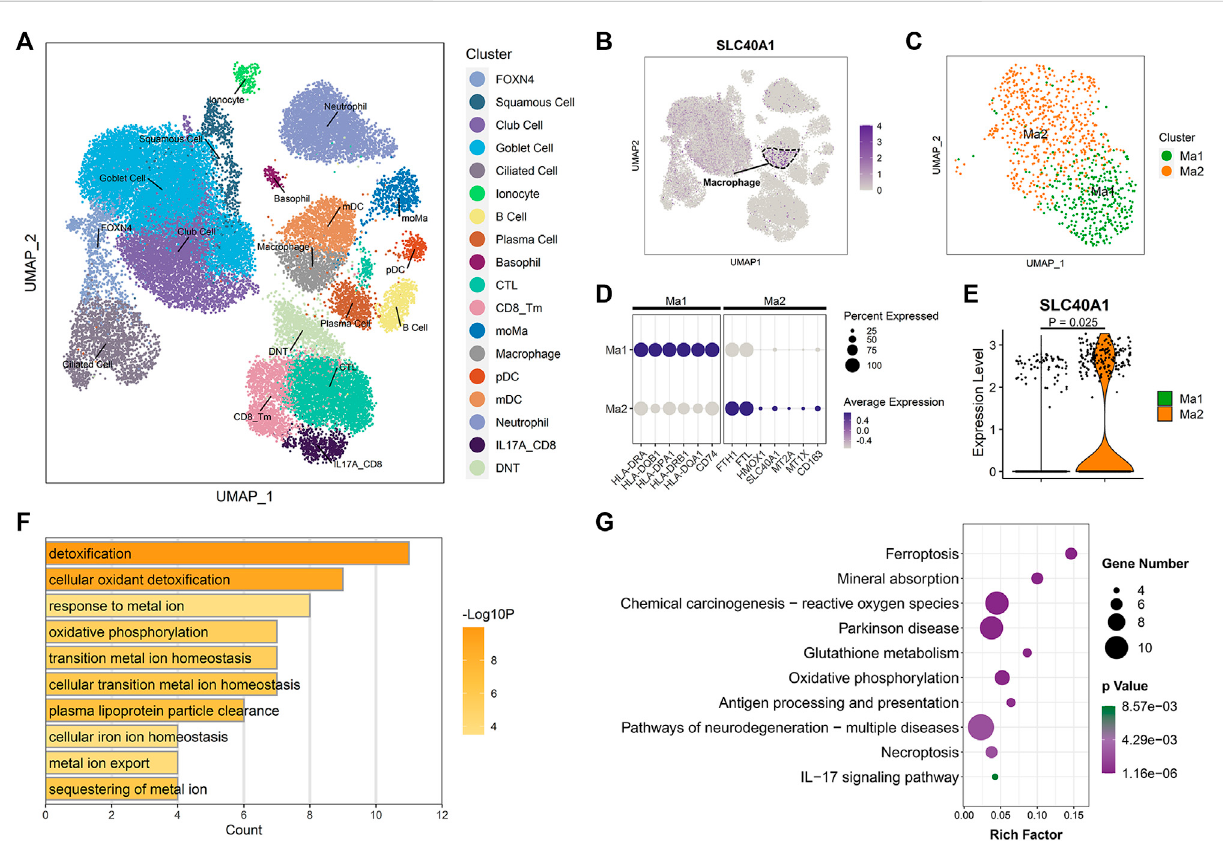
FIGURE 4 Single-cell transcriptomic analysis revealed high SLC40A1-expressing cell subpopulations within airway. (A) Overall cell-type composition of 36,406 cells from 18 healthy children visualized using UMAP. CD8_Tm, memory CD8 + T cells; CTL, cytotoxic T cells; DNT, double-negative T cells; FOXN4, FOXN4 + cells; IL-17A_CD8, IL-17A-expressing CD8 + T cells; mDC, myeloid dendritic cells; moMa, monocyte-derived macrophages; pDCs, plasmacytoid dendritic cells. (B) Feature plot of SLC40A1 expression in all cell populations. (C) Subclustering of macrophages, showing two distinct subpopulations (Ma1 and Ma2). (D) Dot plots of scaled expression levels of canonical markersused to identify each macrophage subtype. Color key from graytopurpleindicateslowtohighexpressionlevels.Dotsizeindicatespercentageofcellsthatexpressedgenes. (E) ViolinplotofSLC40A1expressionfor macrophagesubsets.Statisticalsigni fi cancewasassessedusingWilcoxonrank-sumtest. (F) Enriched GOtermsforDEGsinMa2macrophagesubset. (G) KEGG enrichment analysis of DEGs in Ma2 macrophage subset. GO, gene ontology; KEGG, kyoto encyclopedia of genes and genomes; UMAP, uniform manifold approximation and